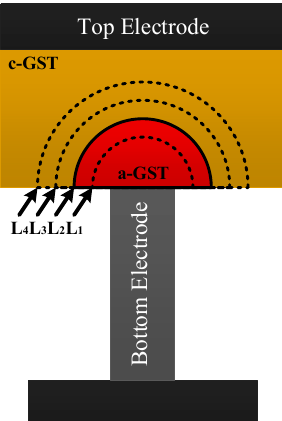
Figure 3. The sectional view of the phase change material layer with different amorphous regions.